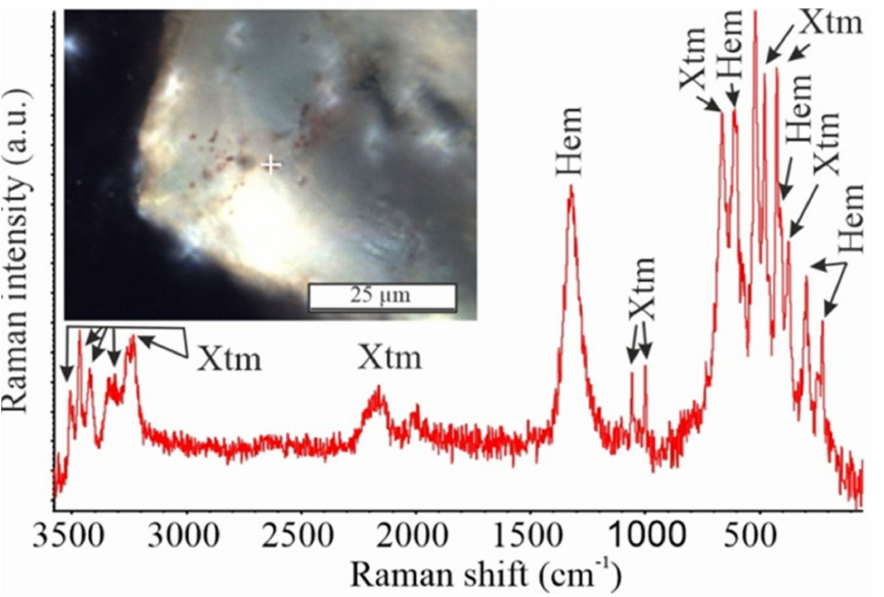
Figure 8. Raman spectra of xenotime hosted in quartz associated with Py-III. Brown inclusions represented by